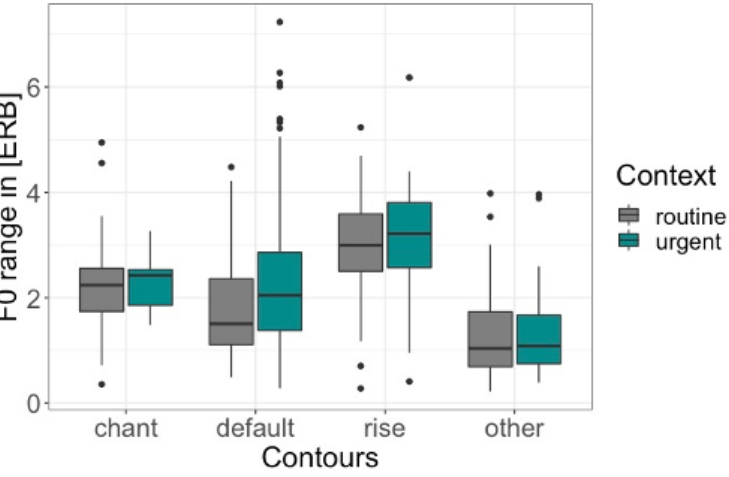
Figure 13. F0 range in the routine and urgent context across different calling melodies in CF.